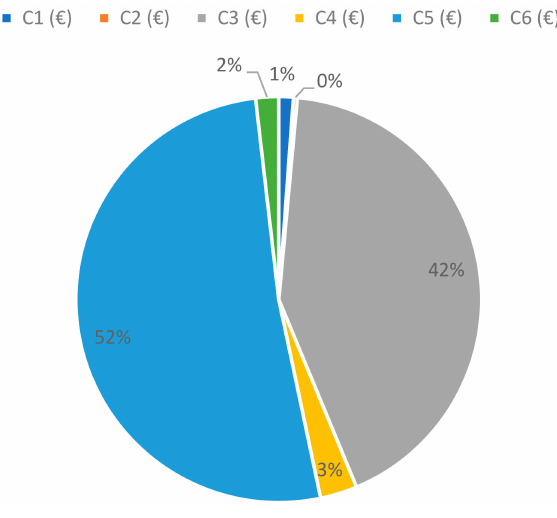
Figure 6. SATH ® platform